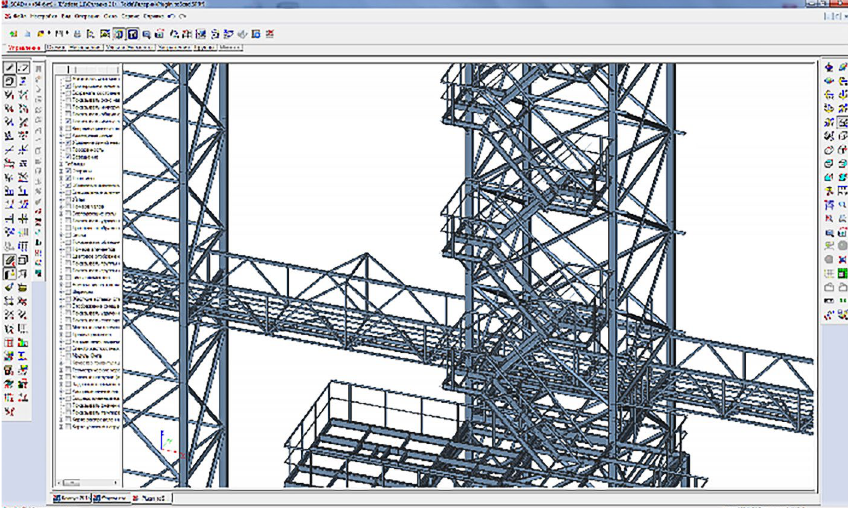
Figure 2. A fragment of the model for a building made of metal